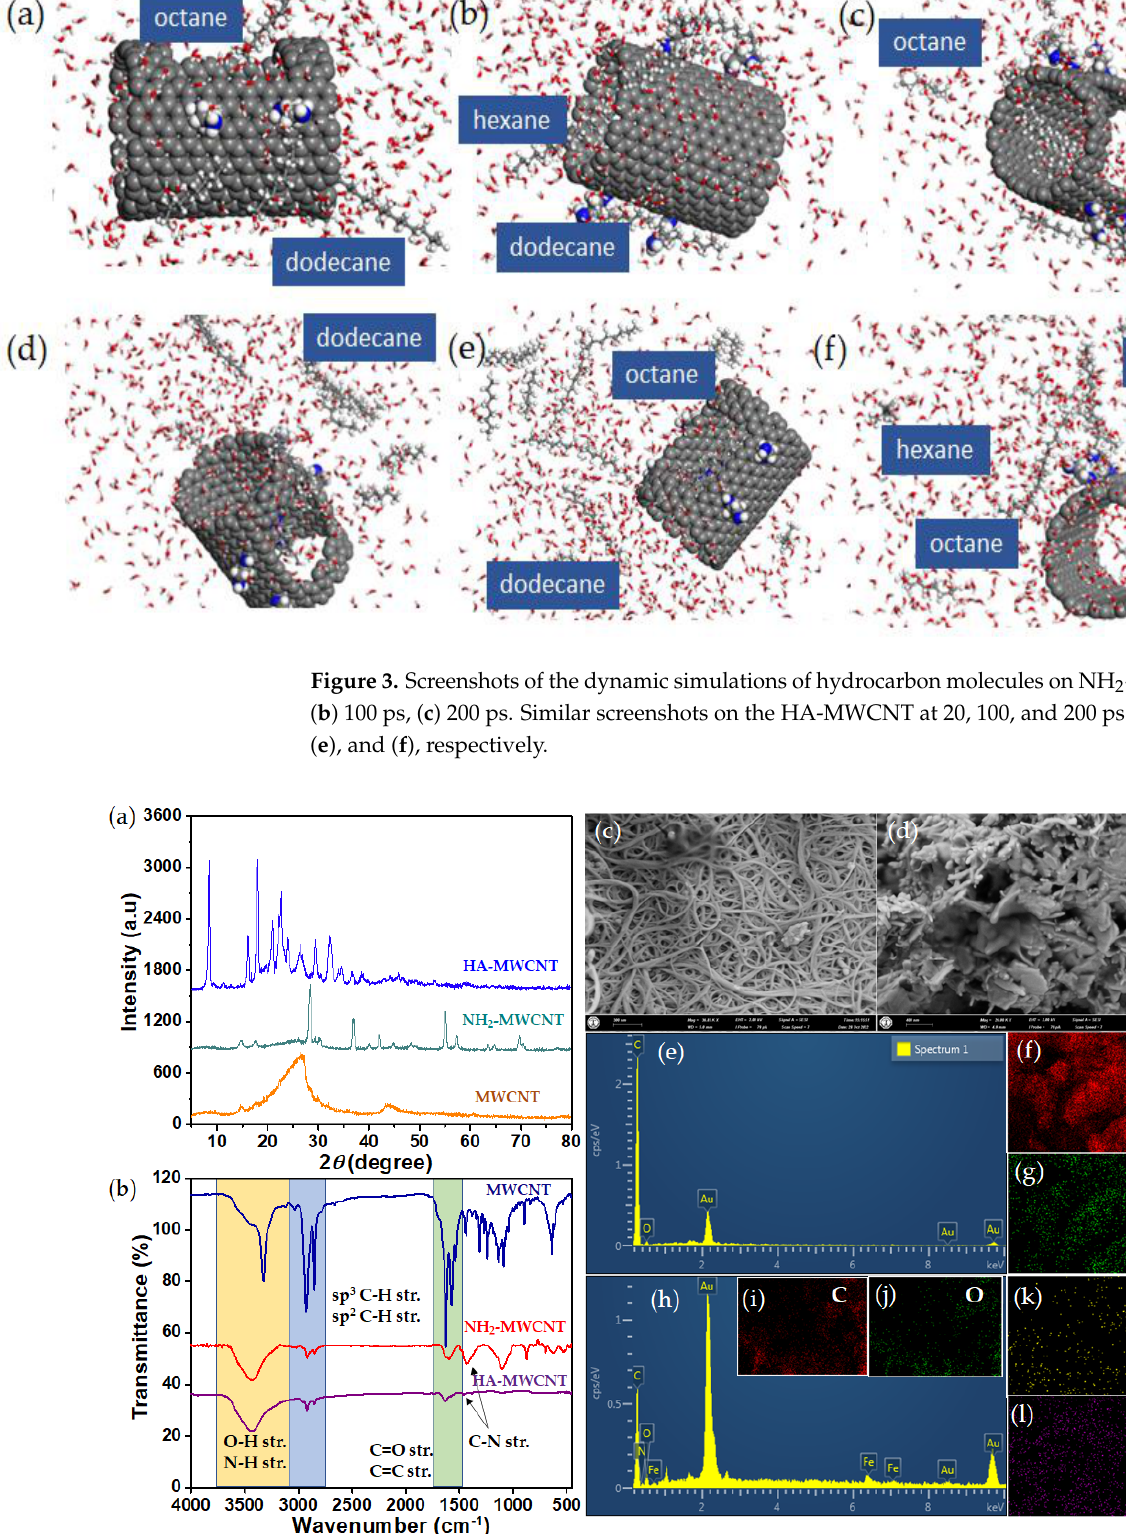
Figure 4. ( a ) X-ray diffraction pattern, and ( b ) FTIR spectra of MWCNT, amine-functionalized MWCNT, and HA-MWCNT. FESEM micrographs of MWCNT and HA-MWCNT are shown in ( c ) and ( d ), while the corresponding EDX and elemental mapping are presented in ( e – g ) and ( h – l ) for MWCNT and HA-MWCNT, respectively.